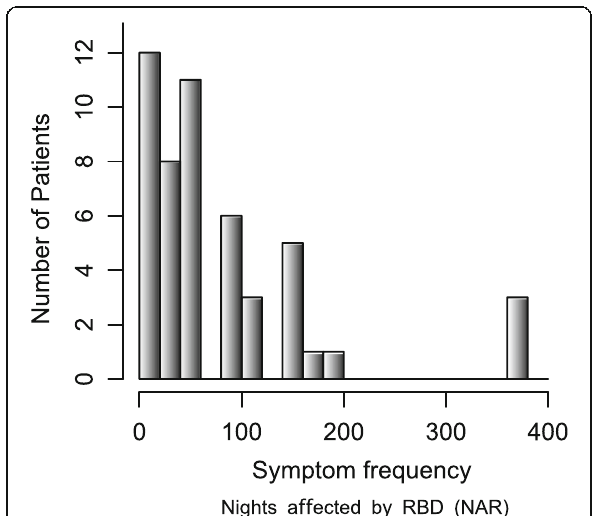
Fig. 1 RBD symptom frequency at sleep clinic visit. A histogram representation of the RBD symptom frequency distribution. The x-axis shows the RBD symptom frequency in NAR units. The y-axis shows the number of patients in every 20 NAR bin group